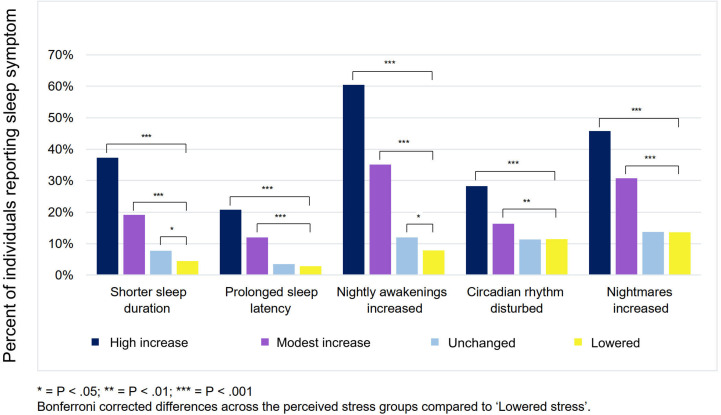
The percentage of individuals reporting worsening sleep (shorter sleep duration, longer sleep latency, more awakenings, disturbed circadian rhythm, and more nightmares) according to their experience of COVID-19–related stress.